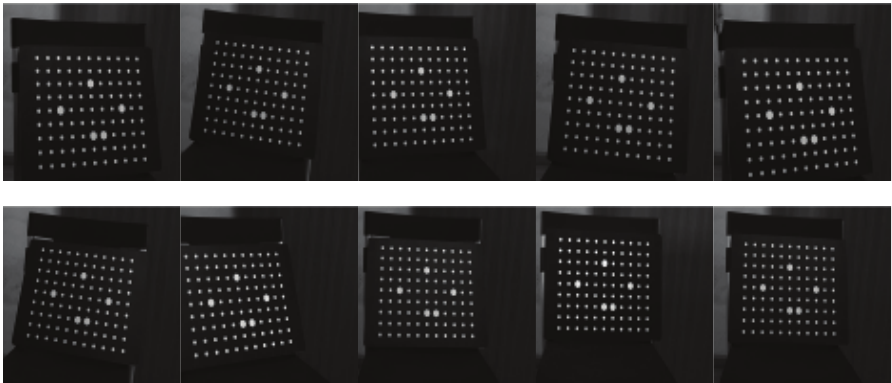
Figure 6: Artificial targets captured by the left and right cameras.